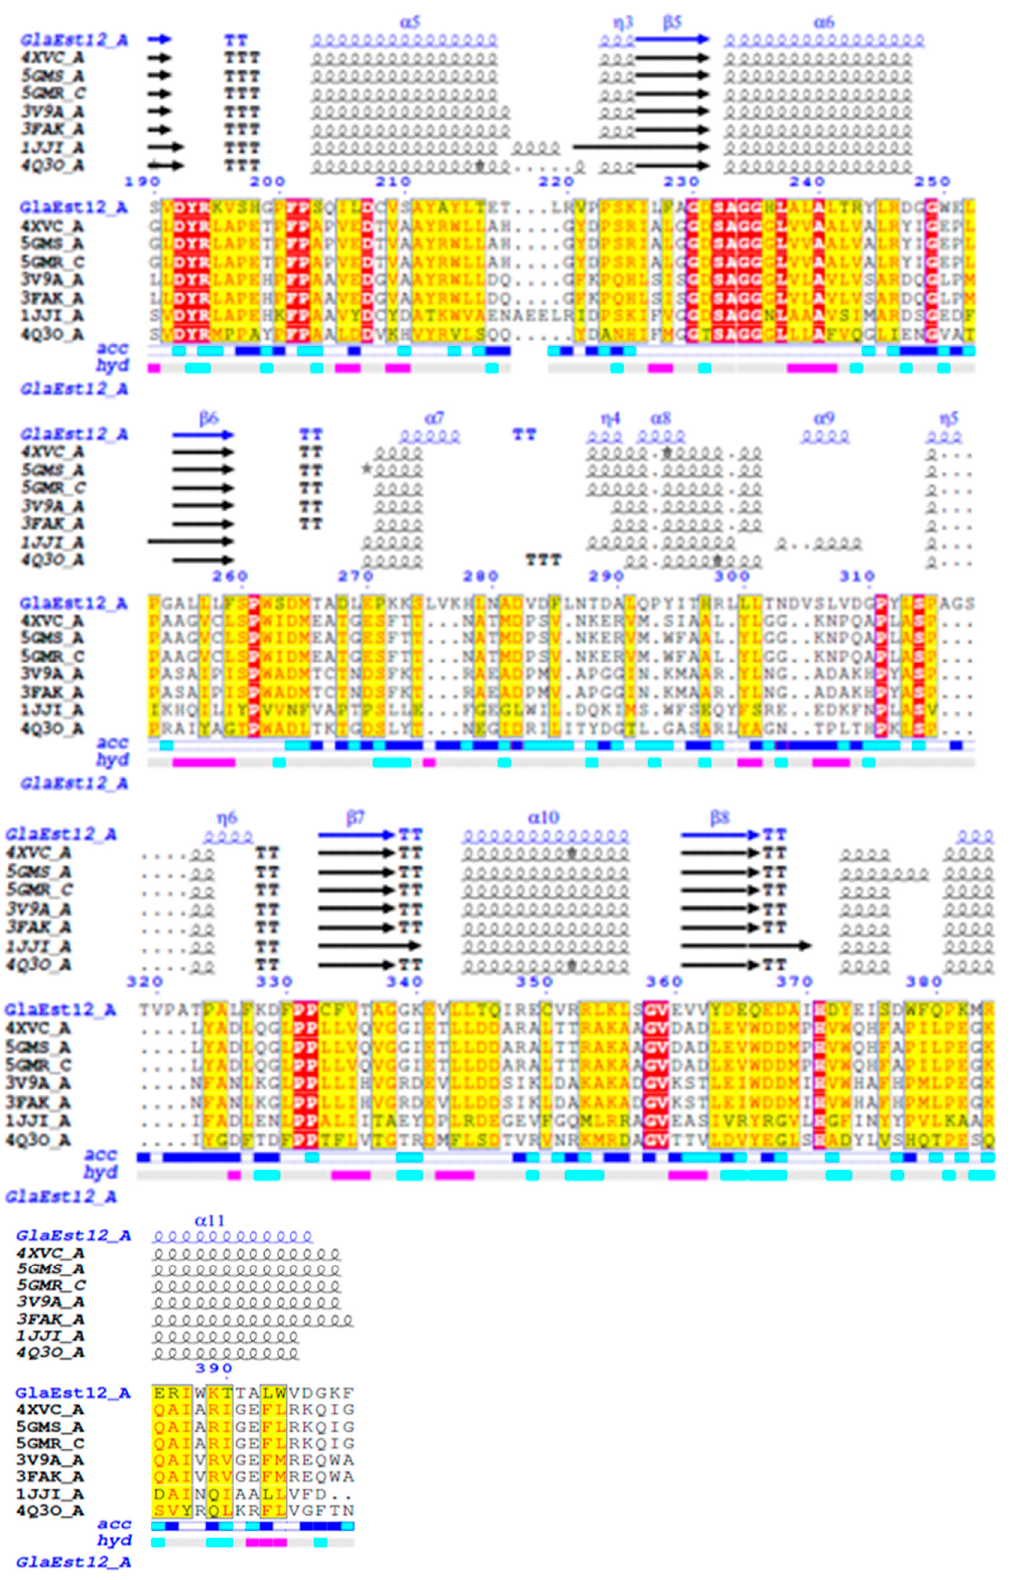
Figure 1. Multiple alignments of amino acid and secondary structure protein sequences from Glaciozyma Antarctica of hormone-sensitive lipase (GlaEst12) esterase with other related proteins. Squiggles indicate helices, arrows indicate β -strands, TT letters indicate a turn, ἠ letters indicate random coil and the catalytic triad are indicated by an arrow symbol. The identical and highly conserved residues are indicated by red and yellow colour, respectively.